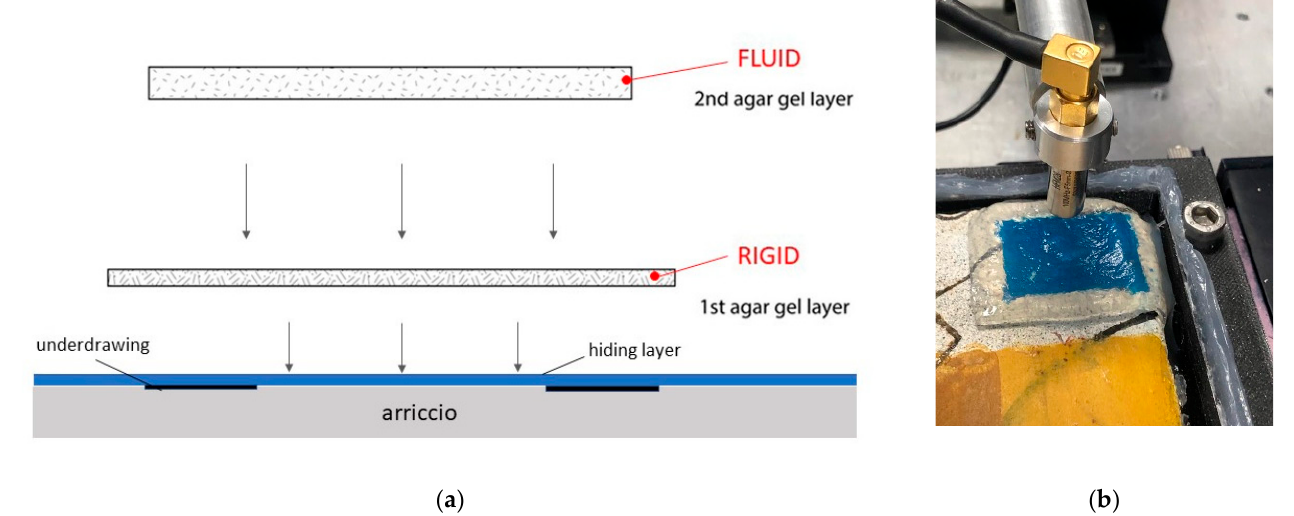
Figure 1. Scheme of agar gel double-layer application ( a ) and visible image illustrating the PA reflectance imaging operation in agar ( b ).